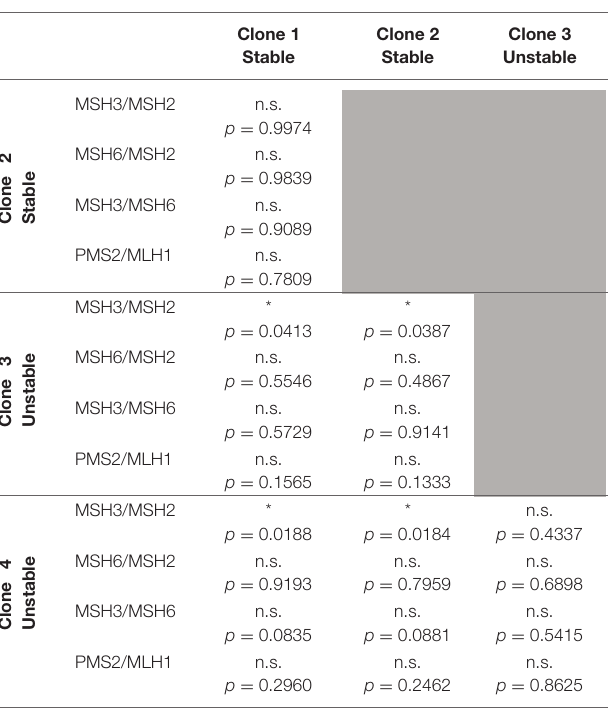
TABLE 3 | Statistical comparison of MMR protein ratios between